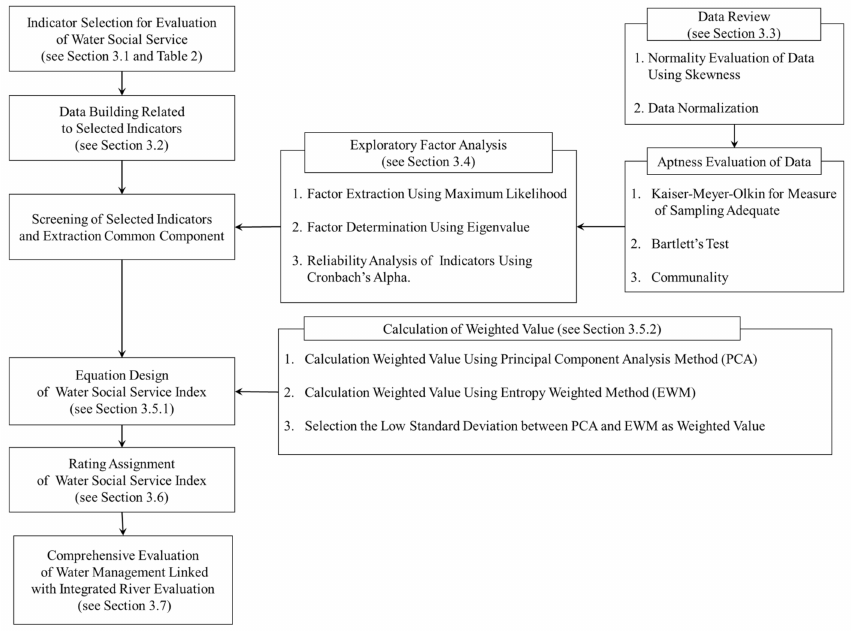
Figure 2. Study process of water social service evaluation and water management comprehen- sive